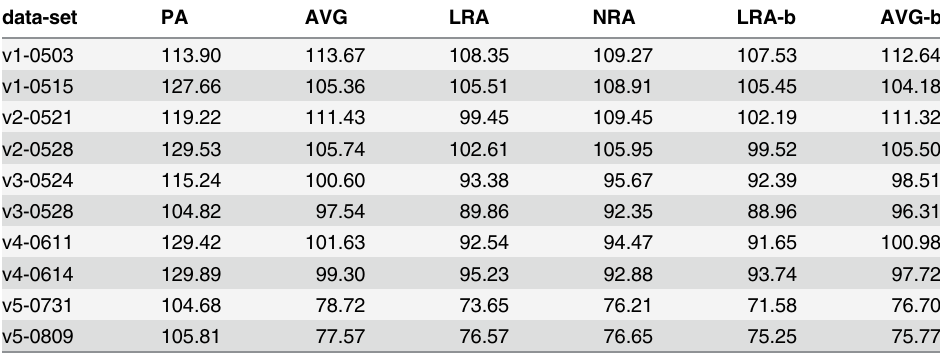
Table 4. Mean ADC values of the two scans per volunteer (selected single slice and region of interest); methods include protocol A and the corresponding average slice using protocol B with and without motion correction; ADC units 10 − 5 mm 2 / s .